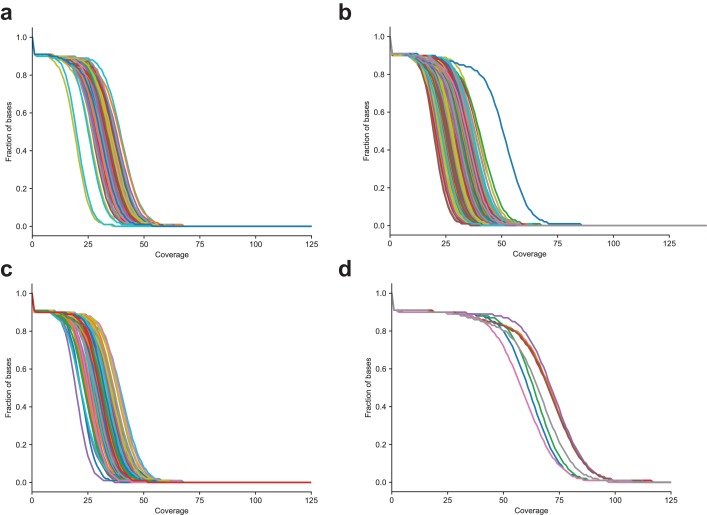
Distribution of sequencing coverage in CEPH/Utah samples (a) The fraction of bases greater than or equal to the specified coverage in the second generation, (b) third generation, (c) first-generation parents sequenced to 30X coverage, and (d) first-generation parents re-sequenced to 60X coverage.